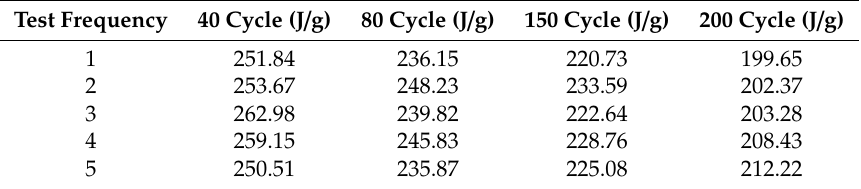
Table 2. The five DSC test results of the SAT / 5 wt.%